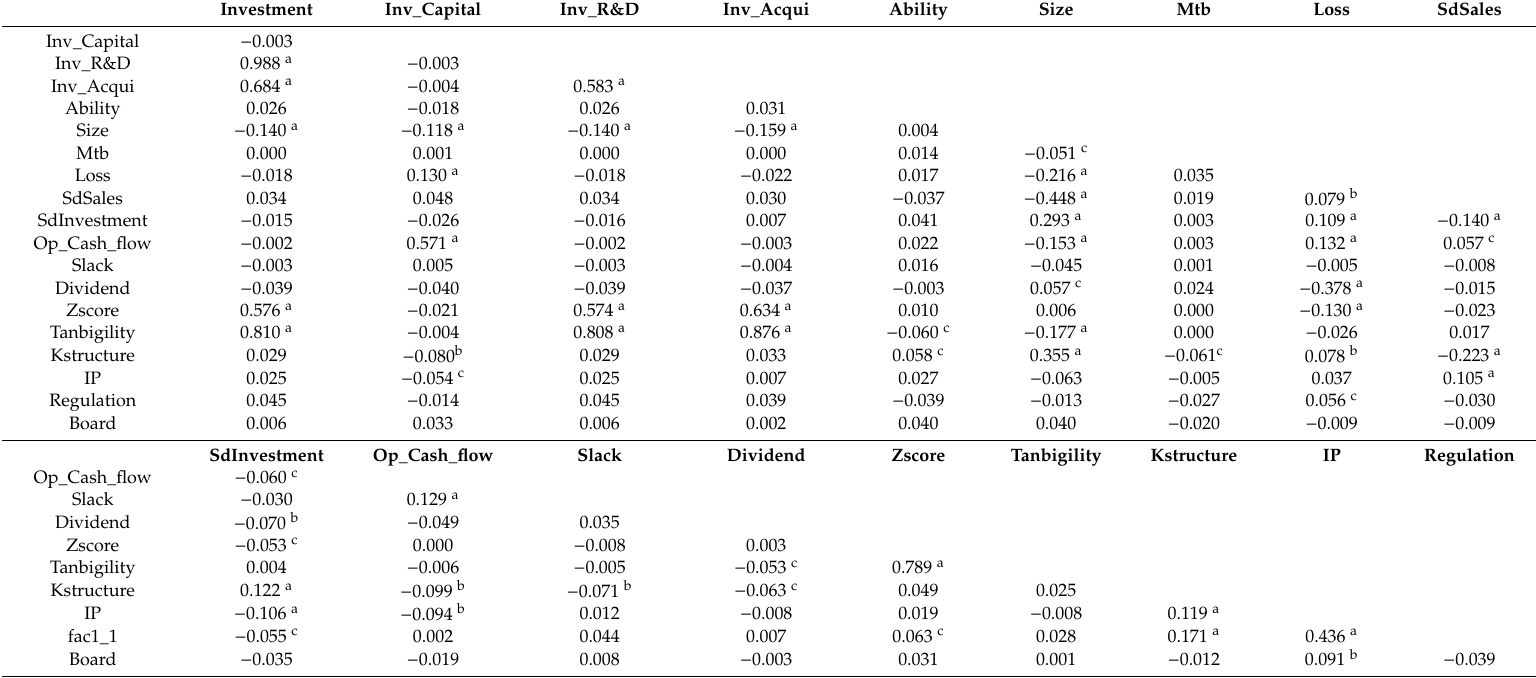
Table 4. Pearson correlation